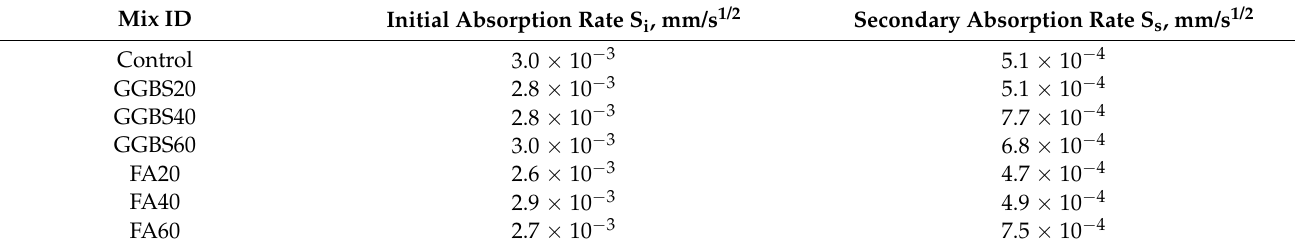
Figure 13. Typical water absorption vs. time curve of ULHS-ECCs. Table 5. Initial and secondary absorption rates of ULHS-ECCs.